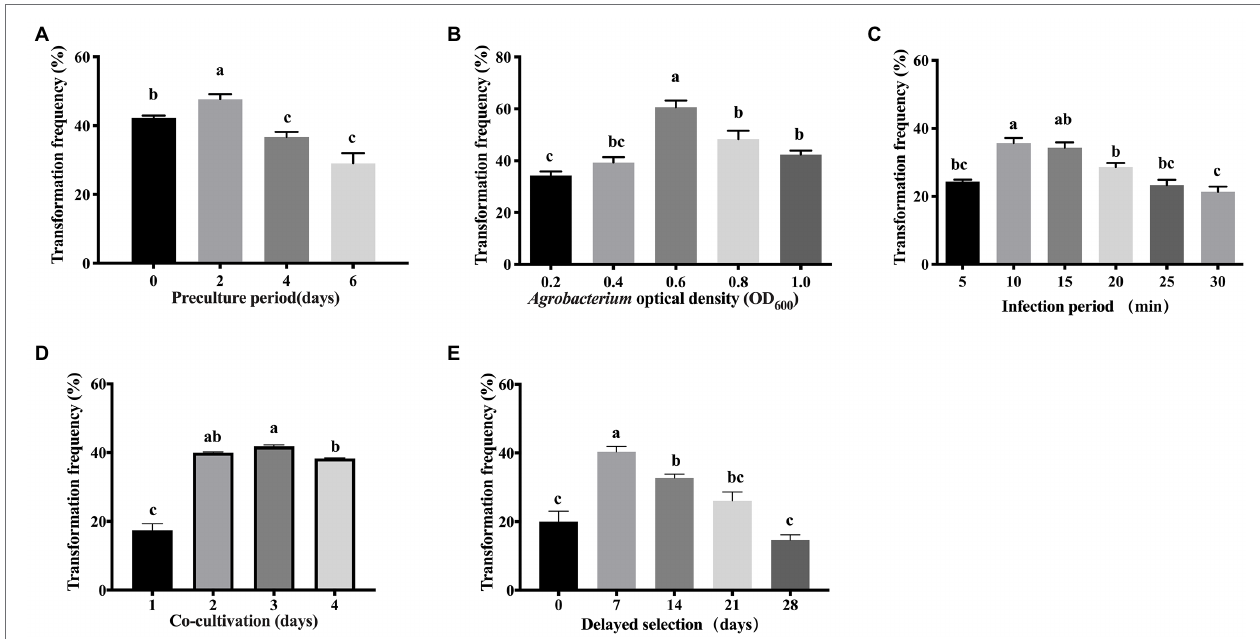
FIGURE 4 | Effects of different factors in the transformation frequency of Liriodendron hybrid embryogenic callus. (A) Pre-culture period. (B) Agrobacterium optical density (OD 600 ). (C) Infection period. (D) Co-cultivation period. (E) Delayed selection. Data correspond to the mean ± SD of three replicates. Column bars with the different letters indicate significant differences at p < 0.05 by ANOVA